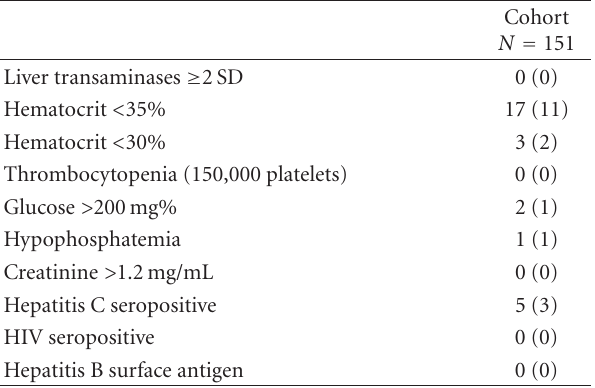
Table 5: Baseline laboratory evaluation prior to receiving HIV nPEP